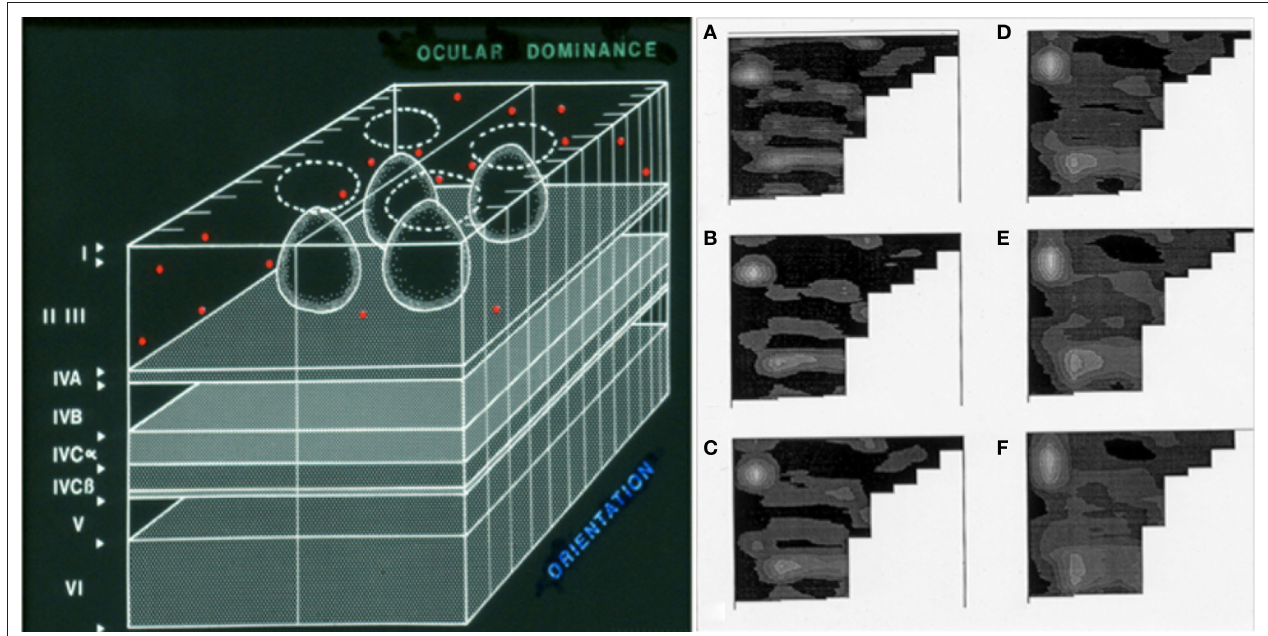
Figure 3 | A light microscopy-level representation of selective circuit targeting in sporadic Alzheimer’s disease. Our work in the primary visual cortex is based on the understanding of its modular organization in primates (summarized in the drawing on the left, from Kuljiš and Rakic, 1990). The hypercolumns that make this region contain iterated circuits in layers II/III that are disposed in “rows” along the tangential plane (i.e., parallel to the pial surface, shown in the left panel). Periodograms (right panel, labeled A–F ) of the distribution of senile plaques in computer-assisted two-dimensional maps of layers II/III of the primary visual (striate) cortex in a patient with Alzheimer’s disease. The non-uniform distribution of the lesions is apparent with virtually all “windowing” parameters, from the highest (A) to the lowest